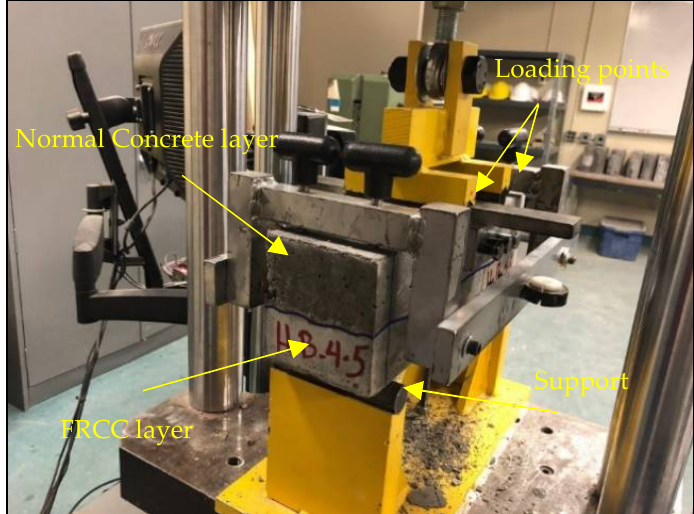
Figure 2. Flexural test set-up.